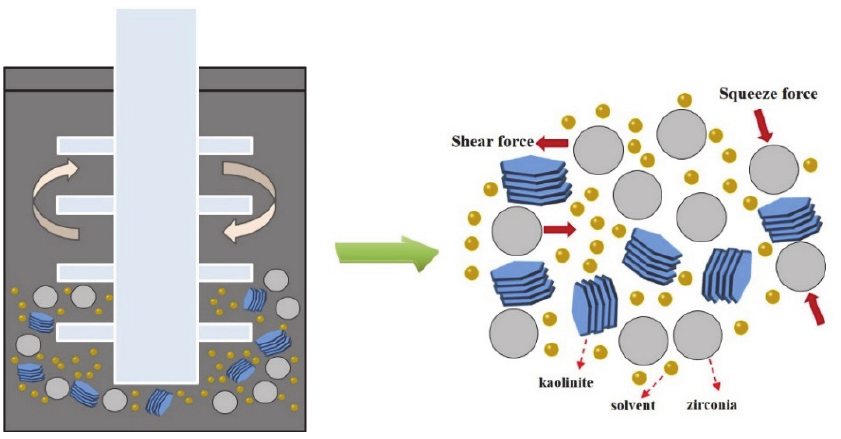
Figure 1. Intercalation process via wet ball